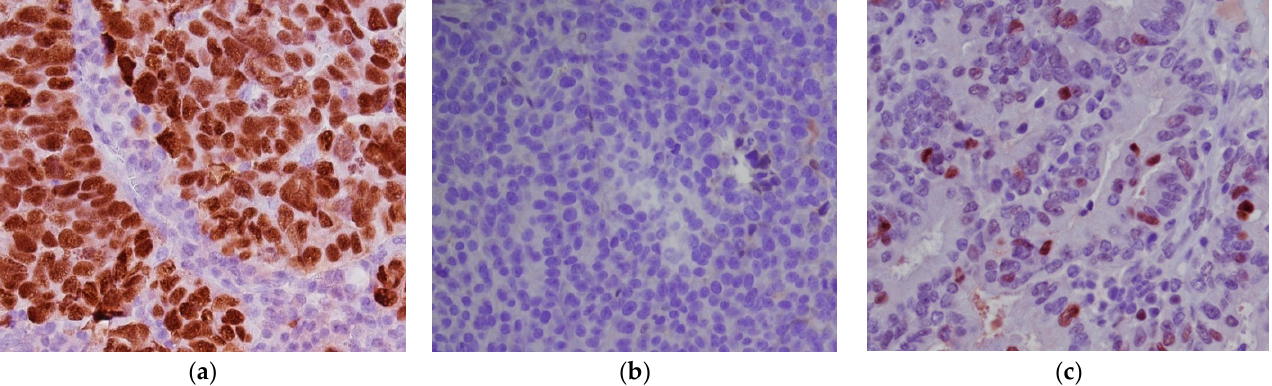
Figure 2. High-grade serous carcinoma, p53 abnormal immunohistochemical patterns. ( a ) p53 overexpression (DO7 clone; x400); ( b ) p53 complete absence of expression (null pattern) (DO7 clone; x400); ( c ) p53 wild-type pattern (DO7 clone; x400).